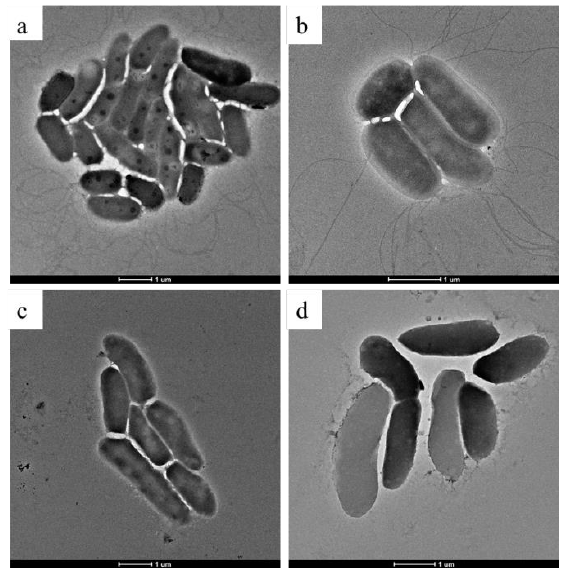
Figure 4. TEM images of Psa after incubation with different concentrations of ethylicin: ( a ) 0 μg/mL; ( b ) 1.80 μg/mL; ( c ) 3.60 μg/mL; and ( d ) 5.40 μg/mL ethylicin. The scale bars for ( a – d ) are 1 μm.